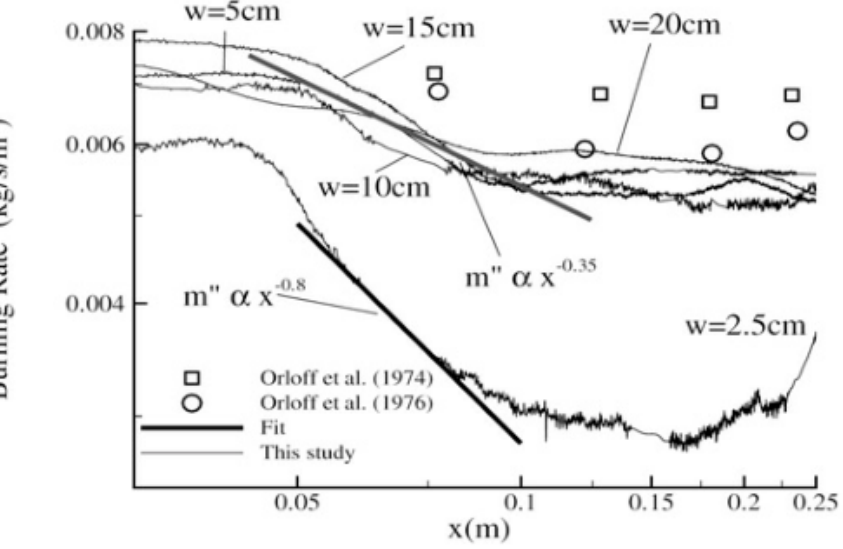
Figure 10. The local MBR along the central axis as a consequence of the separation from the sharp end for all slab thicknesses [114].